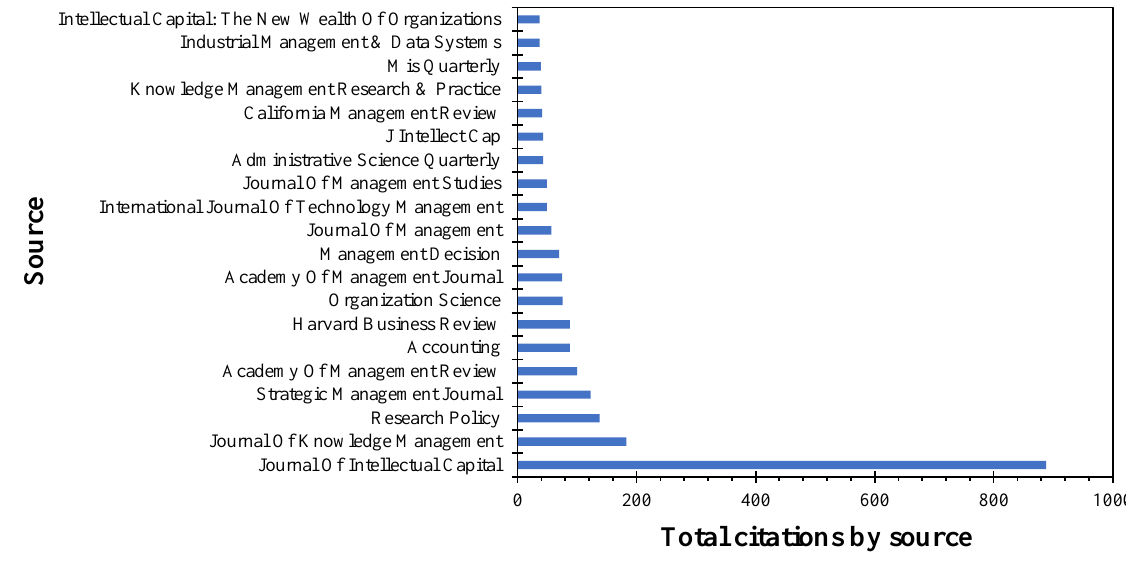
Figure 9. Total citations by source.